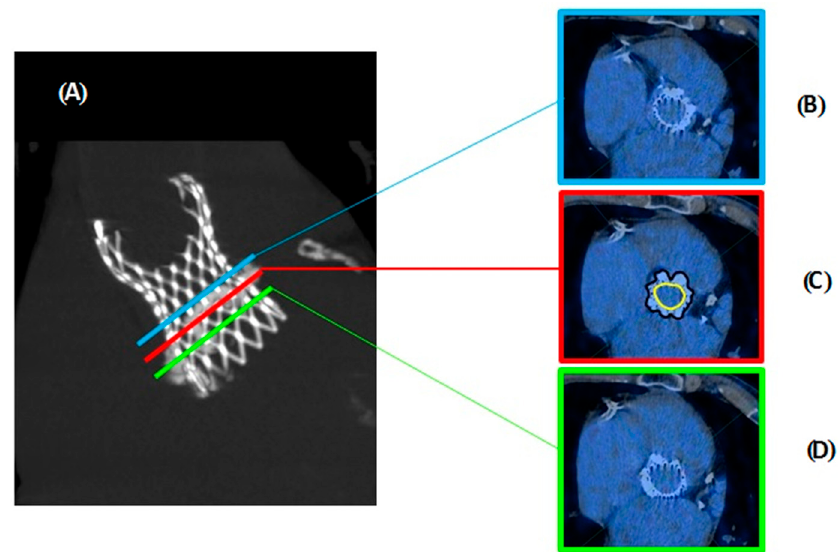
Figure 3. The methodology of leaflet ROI measurement in PET/CT examinations ( A )—TAVI Evolut R Valve on CT—image used for estimation of leaflets localization and the choice of ROI levels. The top, middle, bottom cross-section of value used for measurements were marked with colors; Cross-sections of the valve on PET/CT examination ( B )—on the top level (blue color); ( C )—middle level (red color), yellow and black contour show method of inner and outer outline (ROI) for SUV measurements; ( D )—bottom level (green color).